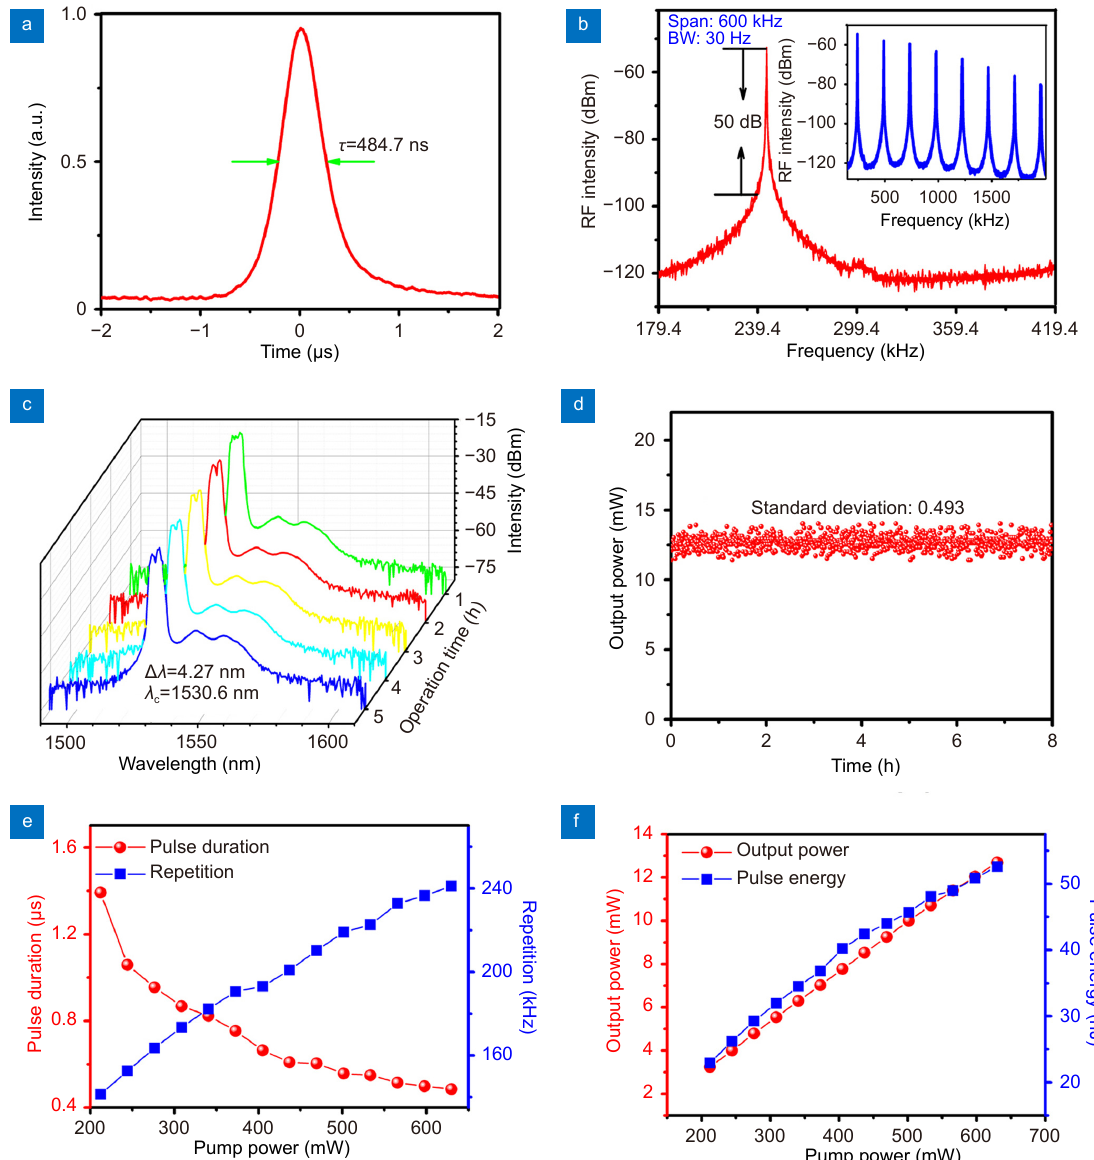
Fig. 3 | The function of the QSFL based on 107 nm-SnS 2 SA. ( a ) The τ of a single pulse. ( b ) RF spectrum (illustration: RF spectrum within a bandwidth of 2 MHz). ( c ) Emission spectrum. ( d ) The monitoring of P out within 8 hours. ( e ) Variation of τ and F rep as functions of P pump . ( f ) Vari- ation of P out and E p as functions of P pump